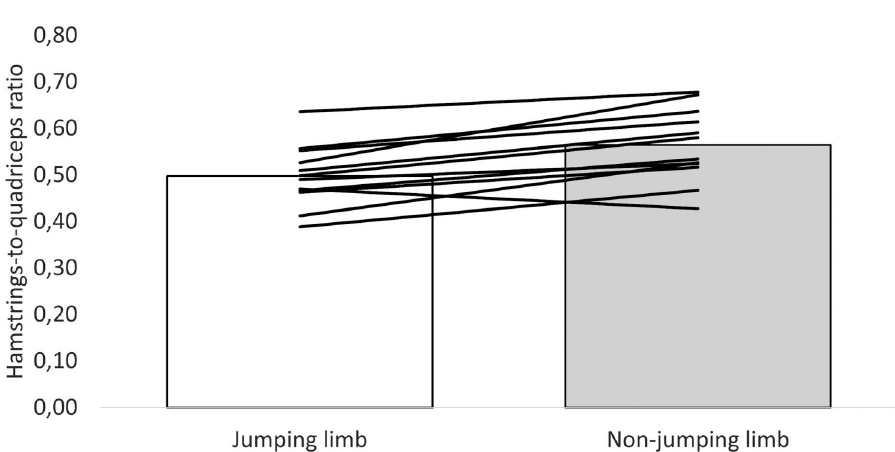
Figure 1 - Hamstring-to-quadriceps ratio values for both limbs. Bars represent the mean and lines represent individual differences between limbs for each athlete. *p < 0.05 compared to the jumping limb.